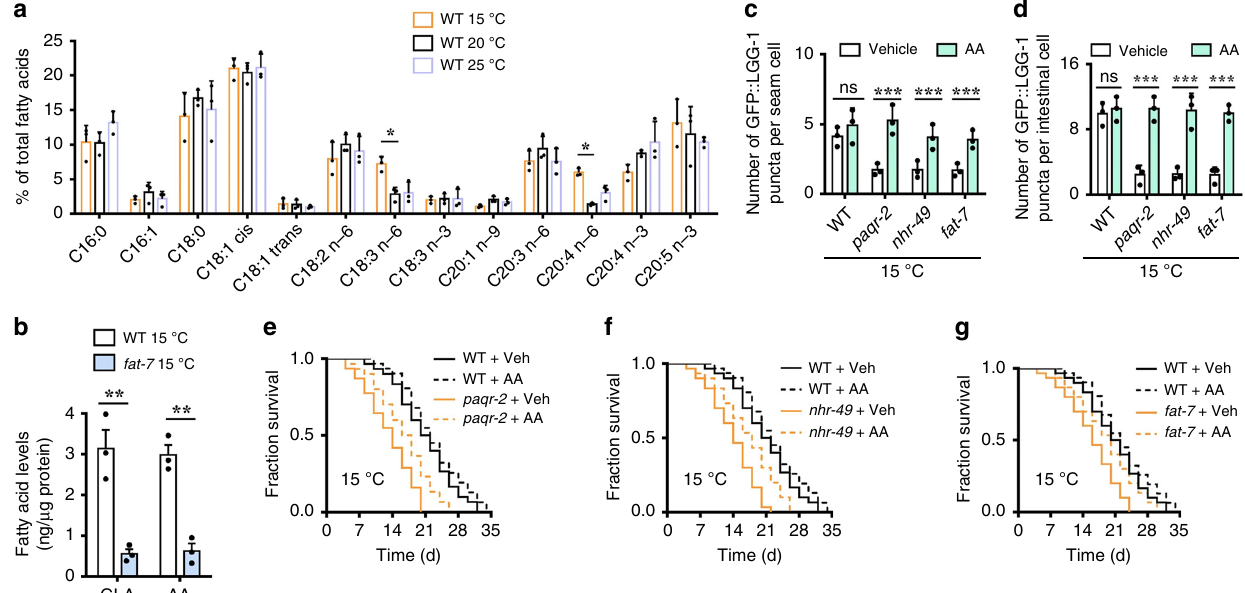
Fig. 4 Arachidonic acid is involved in autophagy at low temperature. a LC-MS pro fi ling of fatty acids in wild-type (WT) worms at 15, 20, and 25 °C. Relative content of individual fatty acid was expressed as percentage of total measured fatty acid. These results are means± SD ( n = 3). * P < 0.05, 15 °C versus 20 ° C. b A mutation in fat-7(wa36) reduced the levels of γ -linolenic acid (GLA, C18:3n6) and arachidonic acid (AA, C20:4n6) in worms at 15 °C. These results are means ± SD ( n = 3). ** P < 0.01 versus WT. c , d Supplementation with AA (10 µ M) signi fi cantly restored autophagy in both seam cells ( c ) and intestinal cells ( d ) in paqr-2(tm3410) , nhr-49(nr2041) , and fat-7(wa36) mutants at 15 °C. These results are means ± SD of three independent experiments ( n = 30 – 35 worms per experiment). *** P < 0.001 versus vehicle. Scale bars: 100 μ m. P -values ( a – d ) were calculated using a one-way ANOVA followed by a Student- Newman-Keuls test. e , f Supplementation with AA (10 µ M) partially restored lifespan in paqr-2(tm3410) ( e ) and nhr-49(nr2041) ( f ) worms at 15 °C. P < 0.05, AA versus vehicle in paqr-2(tm3410) ( e ) and nhr-49(nr2041) ( f ) worms. Veh, vehicle. g Supplementation with AA (10 µ M) fully rescued lifespan in fat-7(wa36) mutant worms at 15 °C. P < 0.01, AA versus vehicle in fat-7(wa36) worms. See Supplementary Data 1 for details. P -values ( e – g )